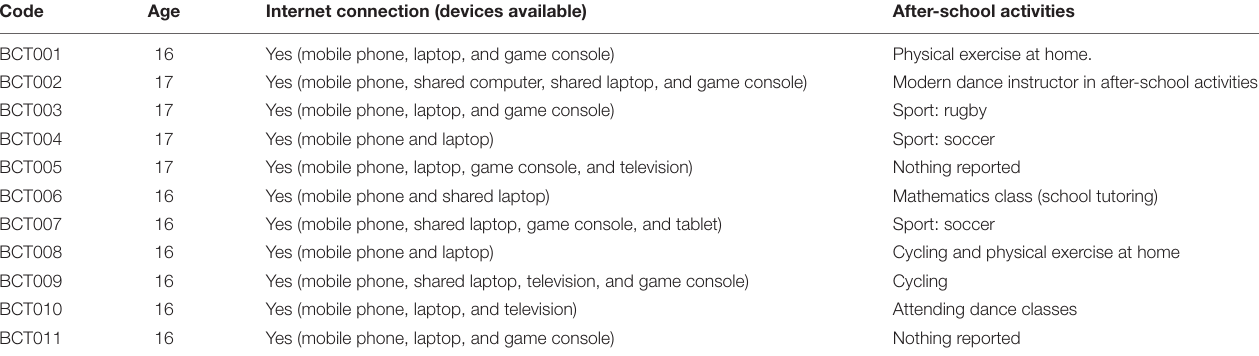
TABLE 2 | Some characteristics of the participants’ learning